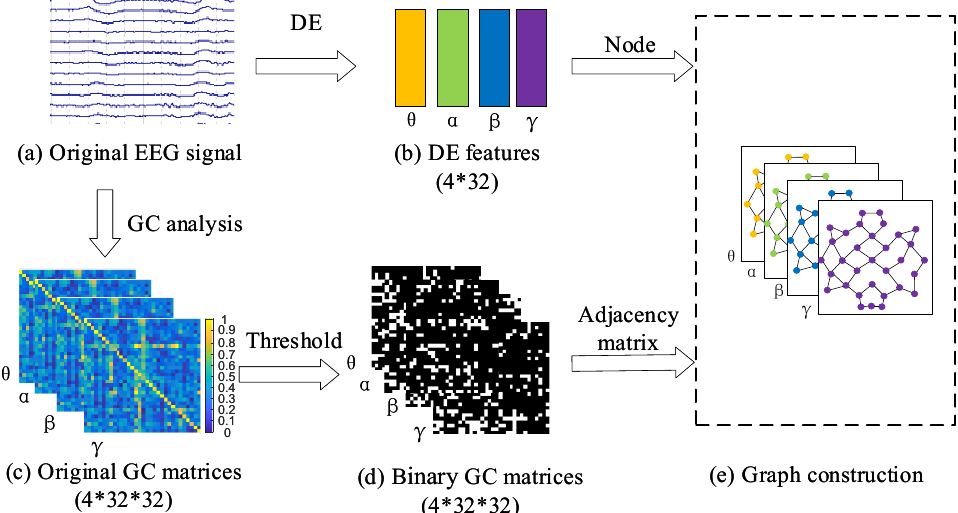
Figure 2. The construction process of the GC-GCN graph feature. ( a ) The original EEG signal. ( b ) The DE features. ( c ) The original GC matrices of the θ , α , β , and γ frequency EEG signal. ( d ) The binary GC matrices with the given threshold selection. ( e ) The final GC-GCN graph